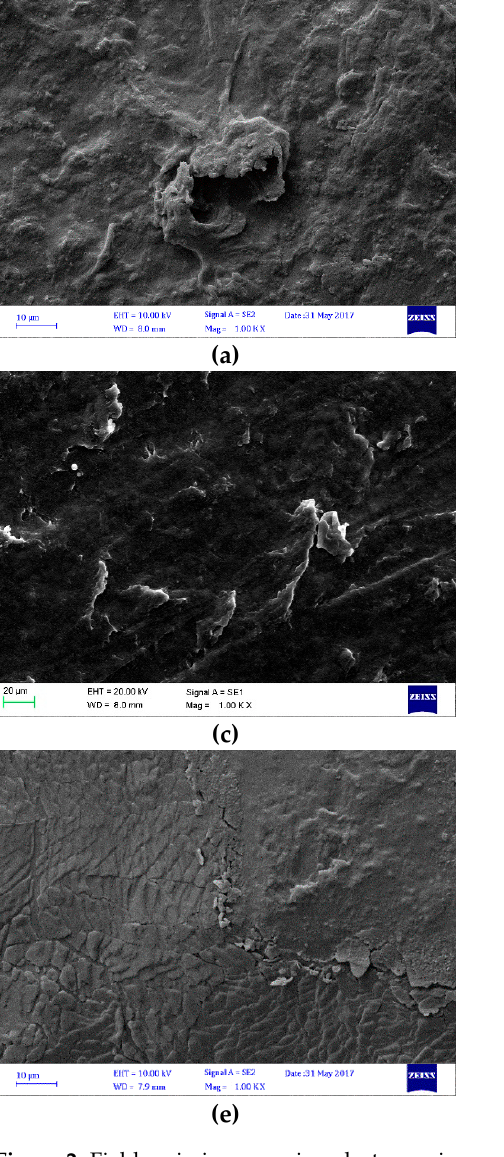
Figure 2. Field emission scanning electron microscopy (FE-SEM) micrographs of the film surface and cross-sectional images prepared with the sol-gel method ( a , b ); sol-gel-ma (1.56% maleic anhydride) ( c , d ); and sol-gel-ma (25% maleic anhydride) ( e , f ). The magnification of surface images was 1.00 K × and that of cross-sectional images was 500×.